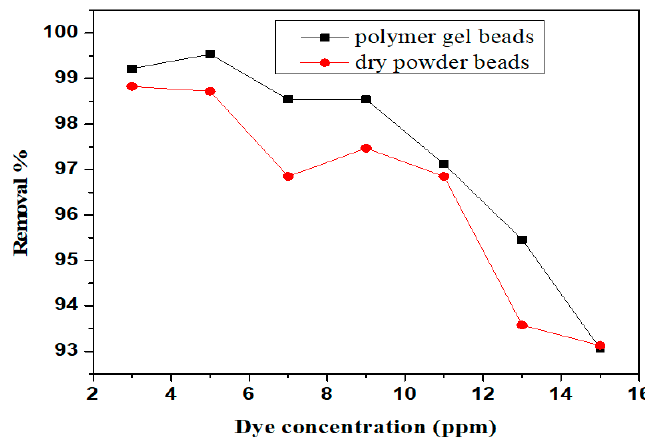
Figure 7. Effect of initial dye concentration on methylene blue (MB) adsorption by polymer gel beads and dry powder beads.